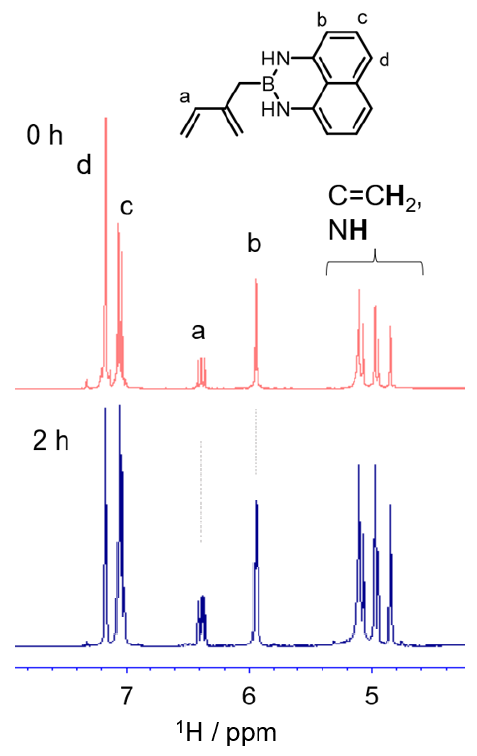
Figure 1. 1 H NMR spectrum of comonomer 2a reacted with excess MMAO (500 MHz, in C 6 D 6 ).